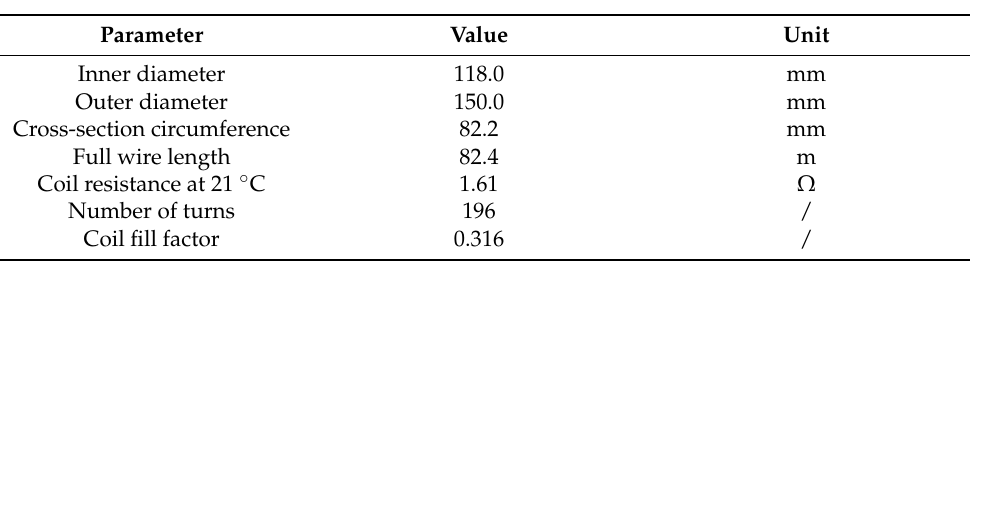
Table 1. Electrical and geometric parameters of the coil, representing the end